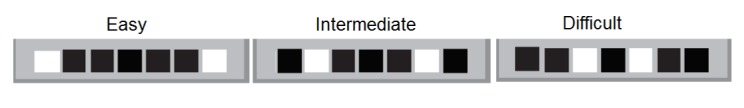
DOI:
http://dx.doi.org/10.7554/eLife.22429.010